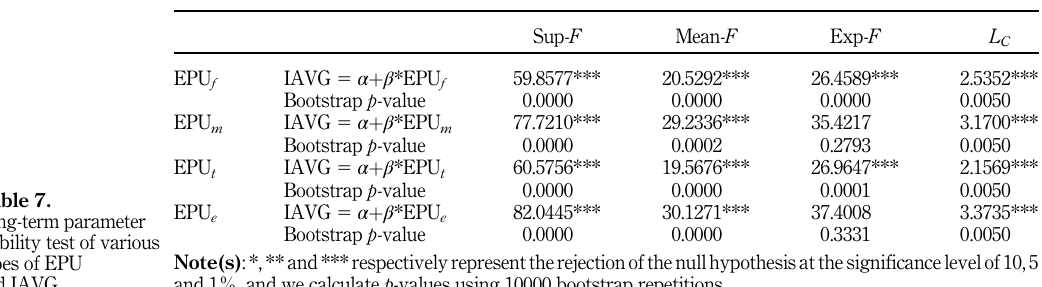
Table 6. Short-term parameter stability test of various types of EPU and IAVG